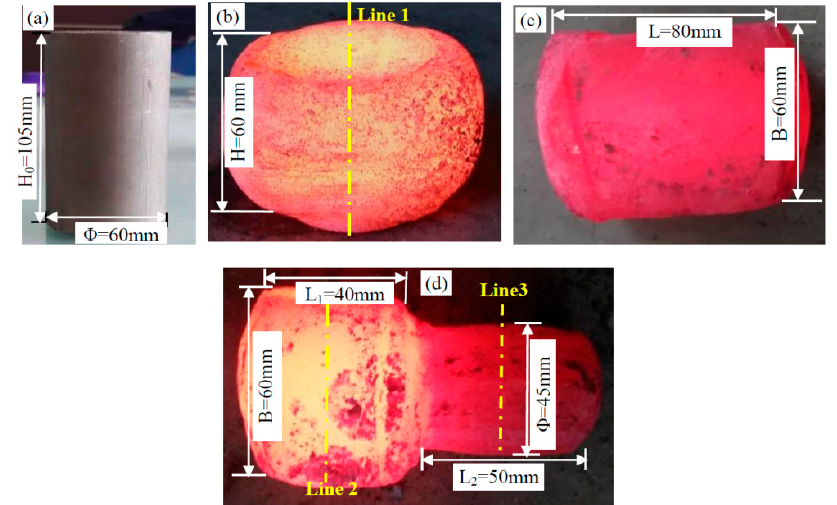
Figure 2. The forging process of the sample: ( a ) forging stock before deformation, φ 60 mm × 105mm; ( b ) first step-upsetting deformation, upsetting ratio K 0 = 1.75; ( c ) second step-squaring process, forging ratio K L1 = 1.37; and ( d ) third step-stretching and chamfering-rounding, forging ratio K L2 = 3.11.